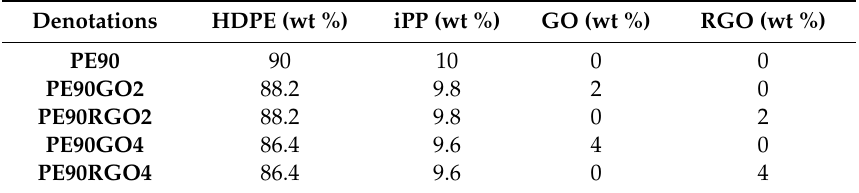
Table 1. Sample denotations and weight fractions. GO: Graphene Oxide, HDPE: High-Density Polyethylene, iPP: Isotactic Polypropylene, PE: Polyethylene, RGO: Reduced Graphene Oxide.